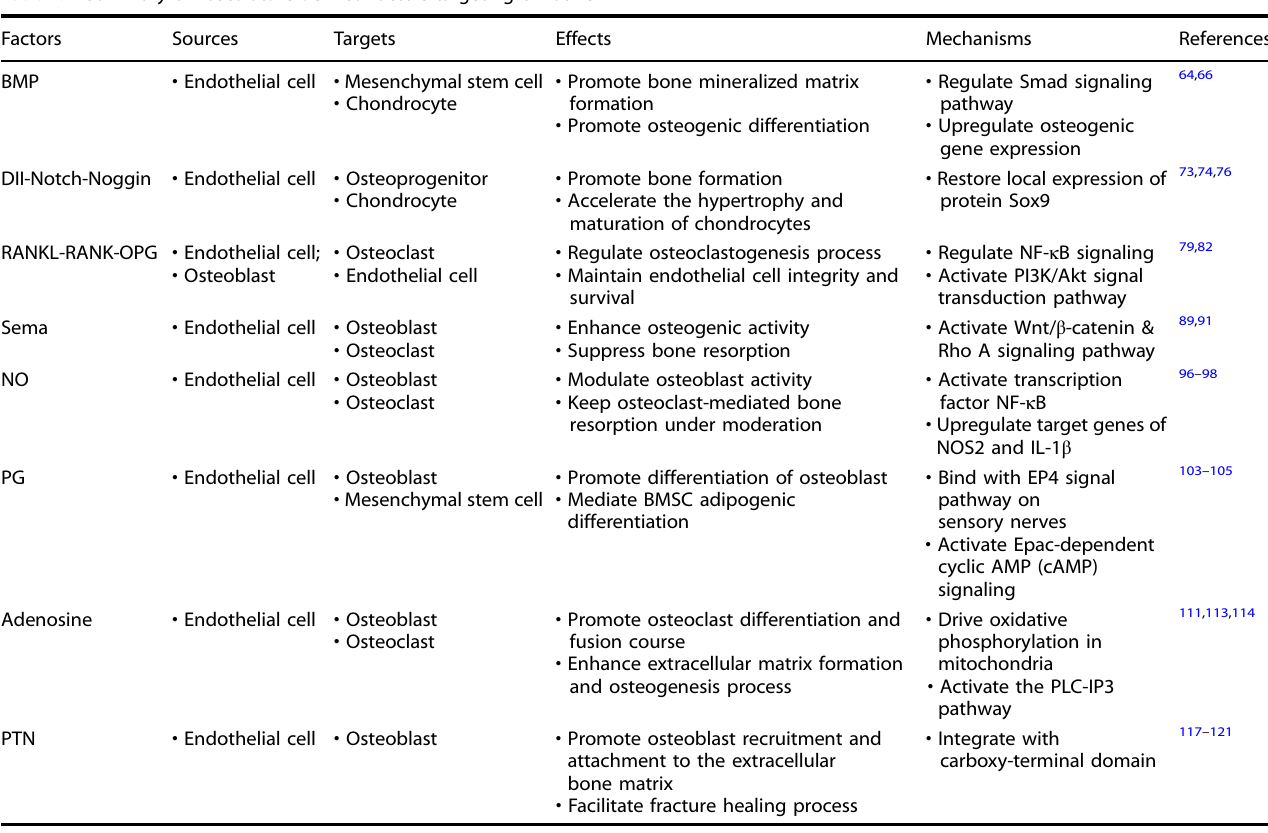
Table 2. Summary of vasculature-derived factors targeting on